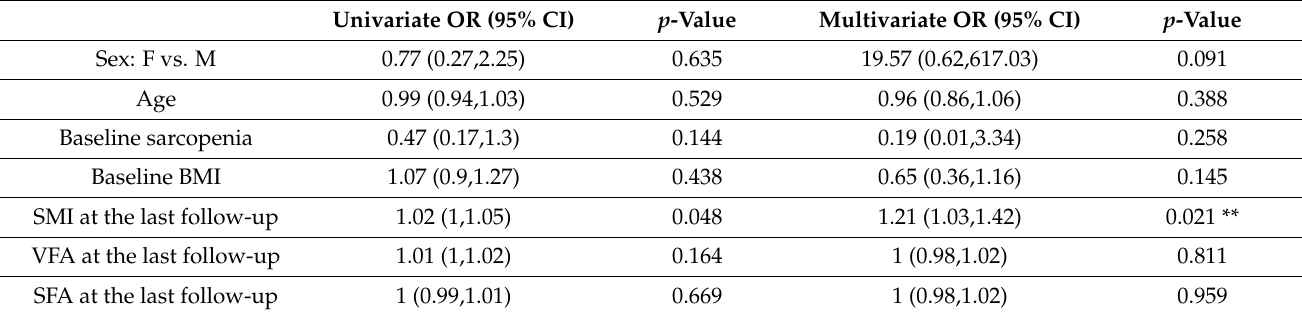
Table 4. Logistic regression analysis predicting